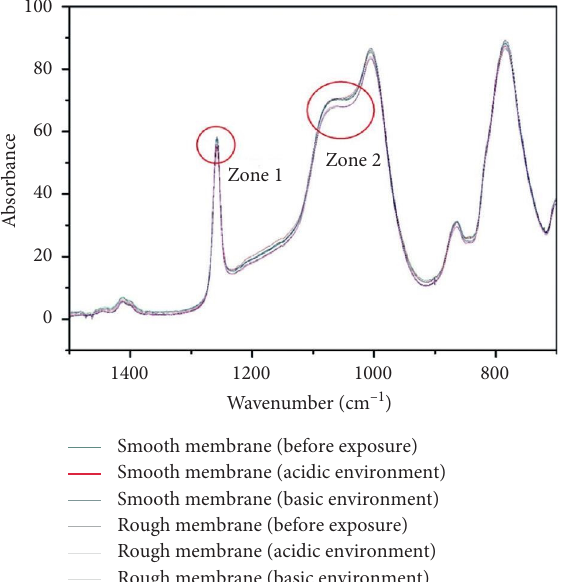
Figure 4: Magnifed FTIR spectra for sample A in the range of 1500–700cm − 1 . Zone 1 shows a zoom of the normalized peak around 1257 cm − 1 and Zone 2 shows a zoom of the region around 1084cm − 1